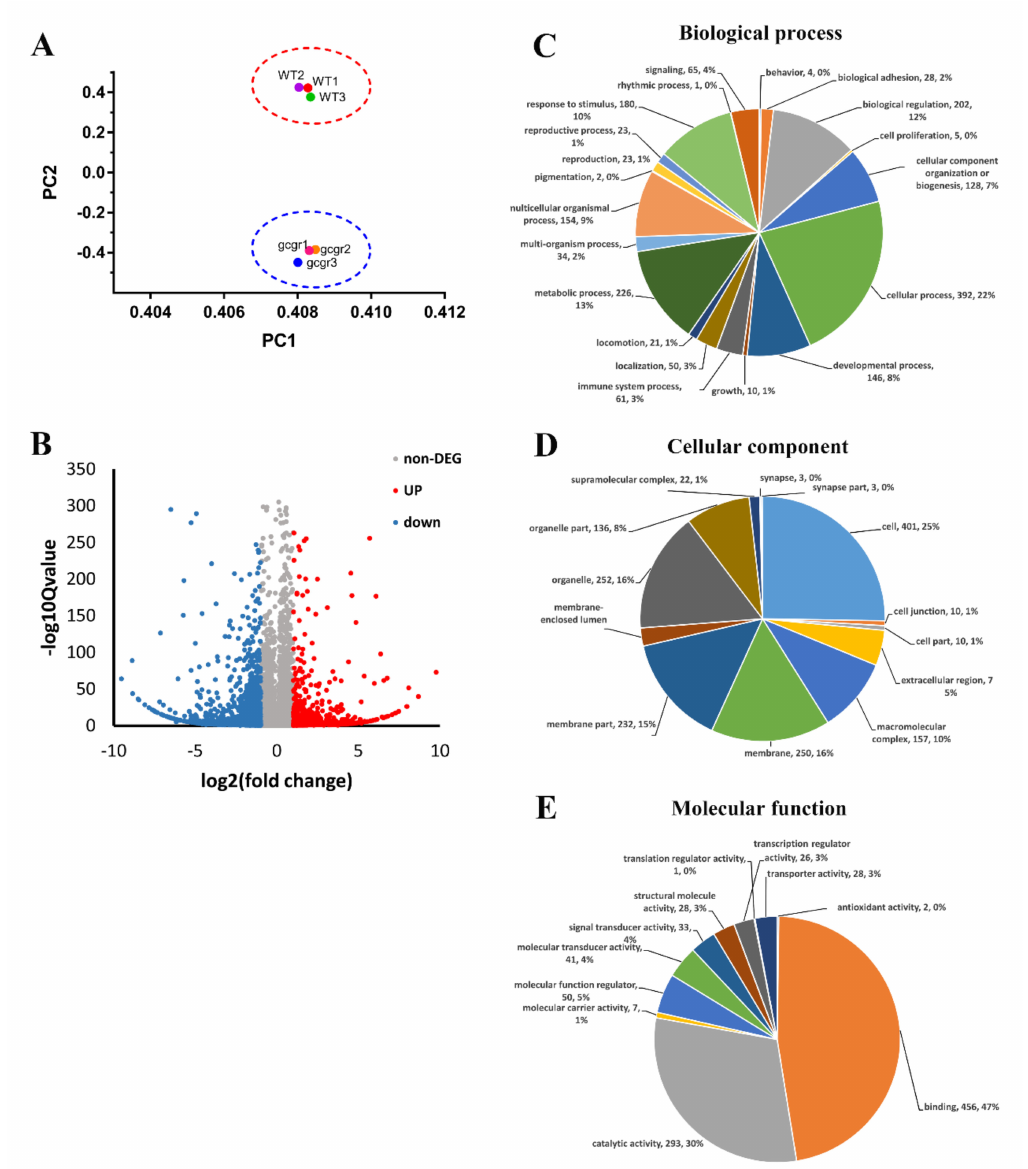
Figure 1. RNA-seq (RNA sequencing) analysis of glucagon receptor ( gcgr − / − ) mutant zebrafish. ( A ) Principal component analysis (PCA) plot of three wildtype and gcgr − / − mutant RNA-seq datasets. Principal component 1 (PC1), and principal component 2 (PC2) were used for analysis. ( B ) Volcano plot of di ff erential expression analysis of gcgr − / − mutant and control larvae showing the relationship between p -value and log fold changes. Red shows upregulated genes and blue downregulated genes. ( C–E ) Gene ontology (GO) enrichment analysis of di ff erentially expressed genes (DEGs) in gcgr − / − mutant zebrafish. The DEGs were assigned to three categories: Biological process, ( C ) cellular component, ( D ) and molecular function ( E ). The names of the GO subcategories, the number of genes, and the proportion of each subcategory are listed by the pie